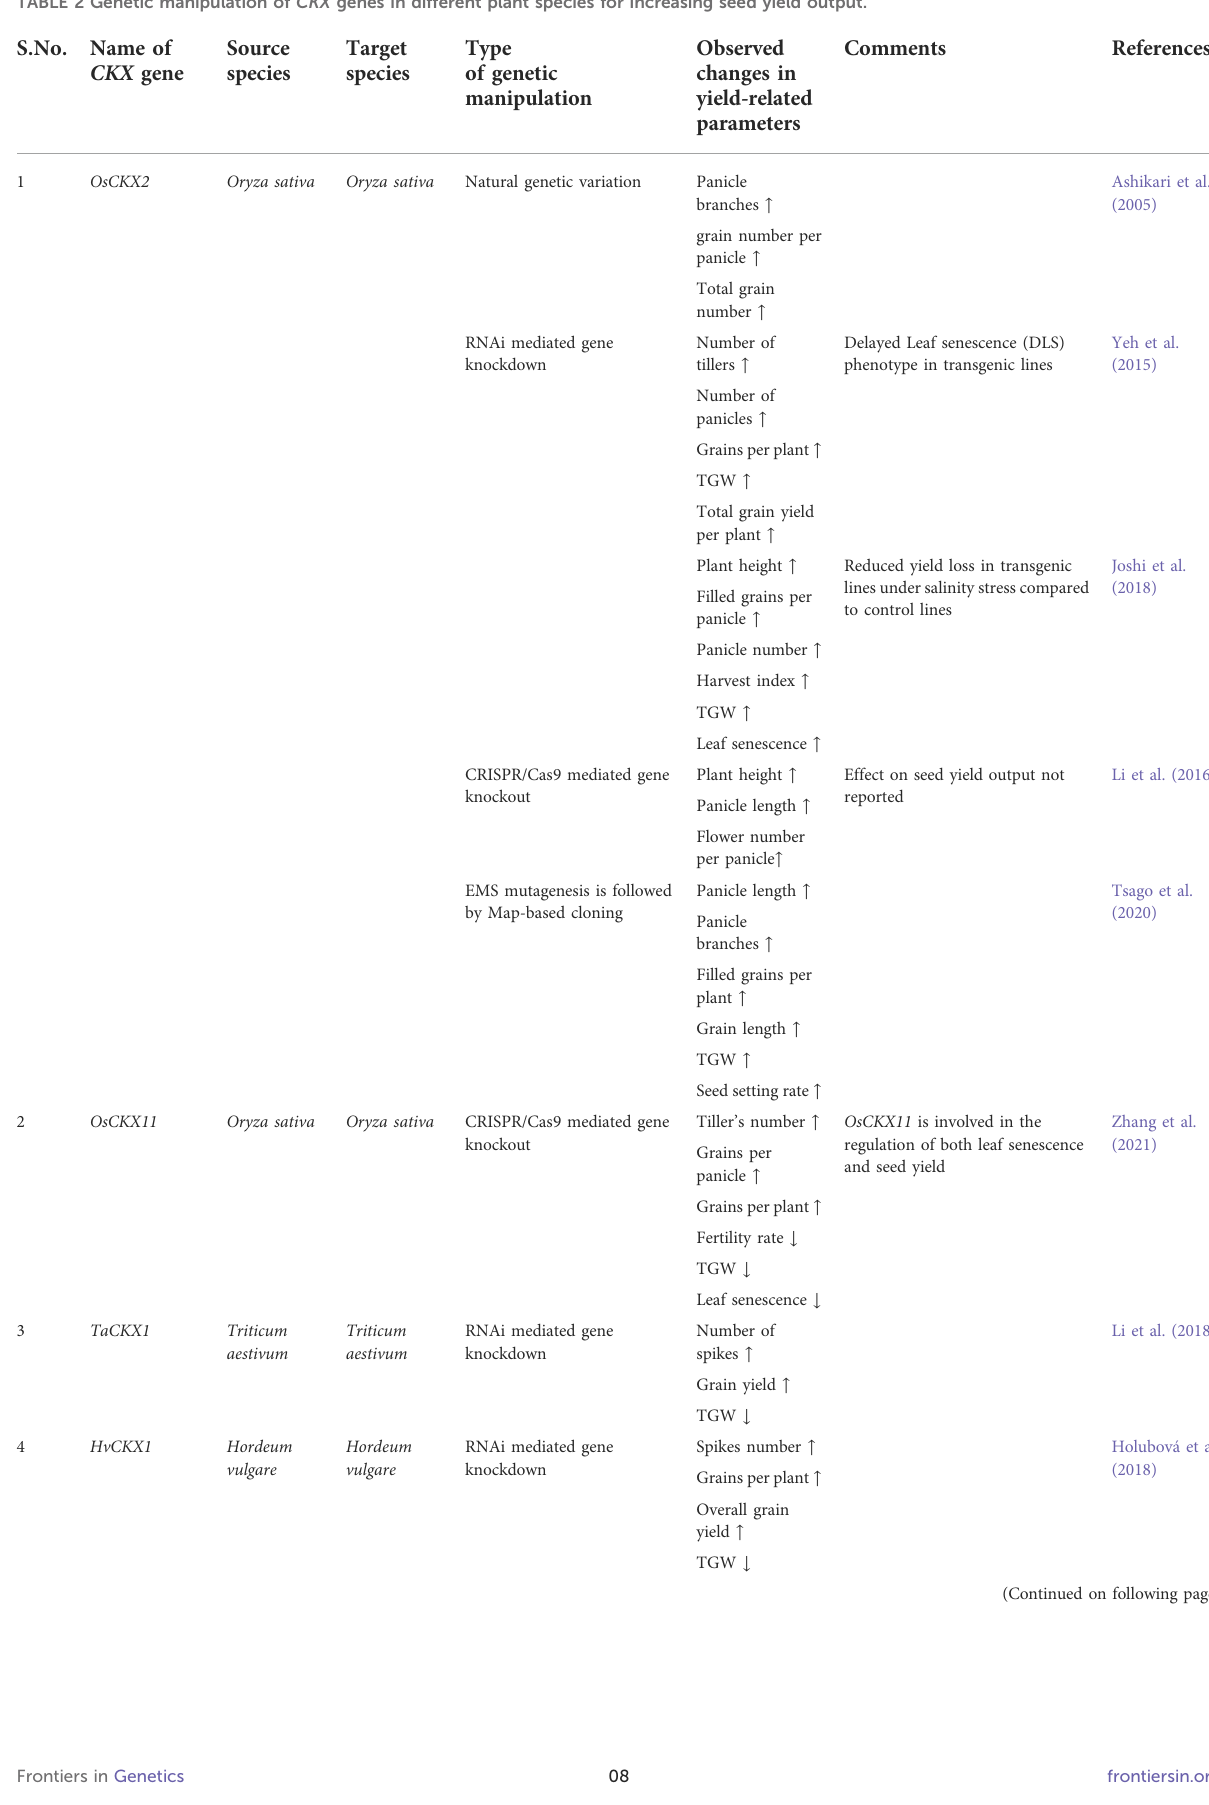
TABLE 2 Genetic manipulation of CKX genes in different plant species for increasing seed yield